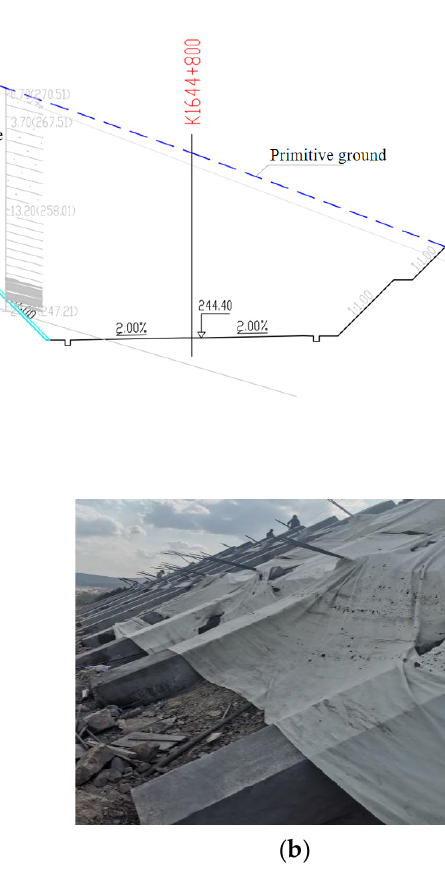
Figure 13. Construction of the anchor cable reinforcement slope. ( a ) Anchor cable construction; ( b ) Frame construction.